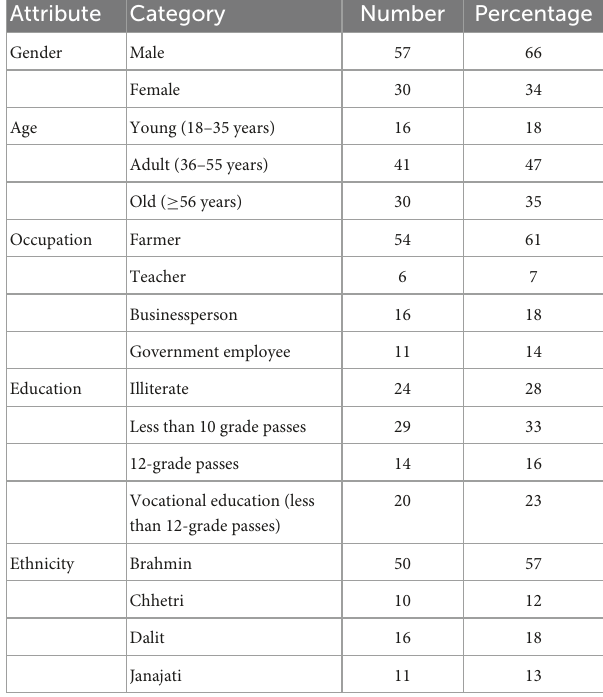
TABLE 3 Sociodemographic characteristics of the